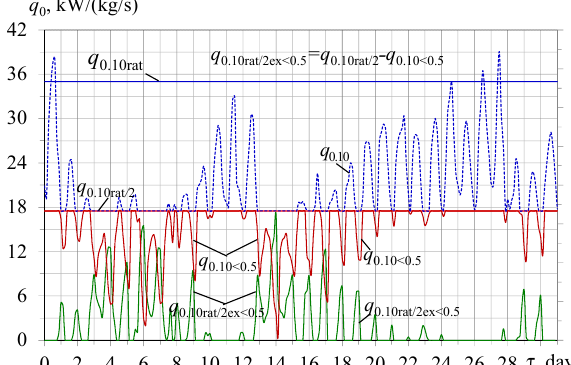
Figure 4. Actual values of thermal load q 0.10 when cooling the air to 10 ° С ; the rest parts q 0.10 ˂ 0.5 of q 0.10 within the unregulated range from 0 to q 0.10rat/2 ; values of rational refrigeration capacity q 0.10rat/2 exceed q 0.10rat/2ex above the actual thermal loads q 0.10 ˂ 0.5 within the unregulated range from 0 to q 0.10rat/2 : q 0.10rat/2ex ˂ 0.5 = q 0.10rat/2 − q 0.10 ˂ 0.5 ; q 0.10 ˂ 0.5 is marked for q 0.10 < 0.5 q 0.10rat .